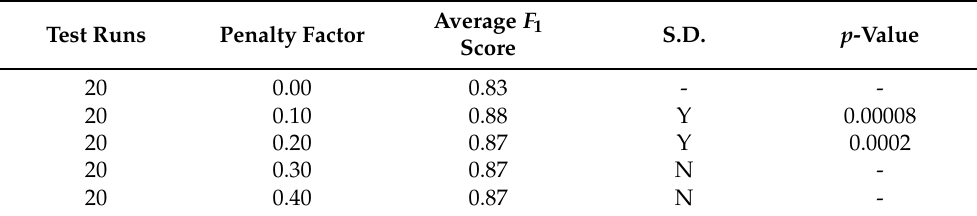
Table 10. Effect of Penalty Factor on Accuracy.